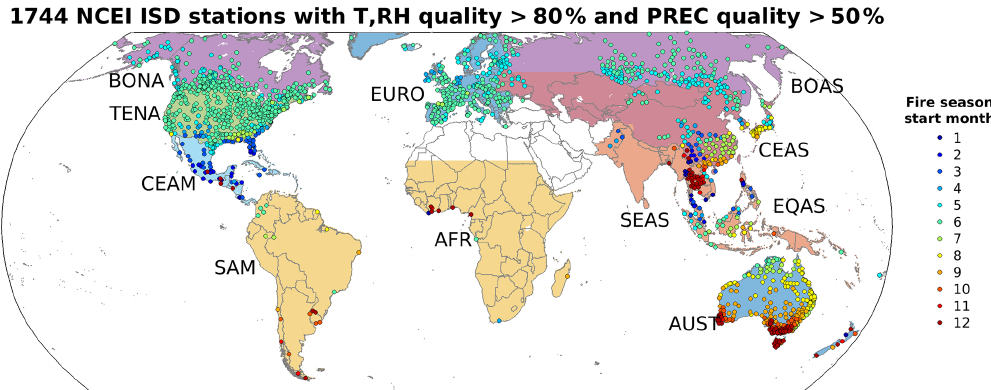
Figure 1. National Centers for Environmental Information (NCEI) Integrated Surface Database (ISD) stations with at least 80% completeness of 12:00LT observations of 2m temperature (TEMP) and 2m relative humidity (RH) and 50% completeness of daily total precipitation (PREC) over 2004–2018. Stations are colored by the starting month of their 4-month peak fire weather season. Global Fire Emissions Database (GFED; van der Werf et al., 2017) regions are indicated by the labels and shading. The region definitions are boreal North America (BONA), temperate North America (TENA), central America (CEAM), South America, combined GFED Northern and Southern Hemisphere South America (SAM), combined GFED Northern and Southern Hemisphere Africa (AFR), Europe (EURO), boreal Asia (BOAS), central Asia (CEAS), southeastern Asia (SEAS), equatorial Asia (EQAS), and Australia and New Zealand (AUST). The GFED Middle East region was excluded due to a lack of weather